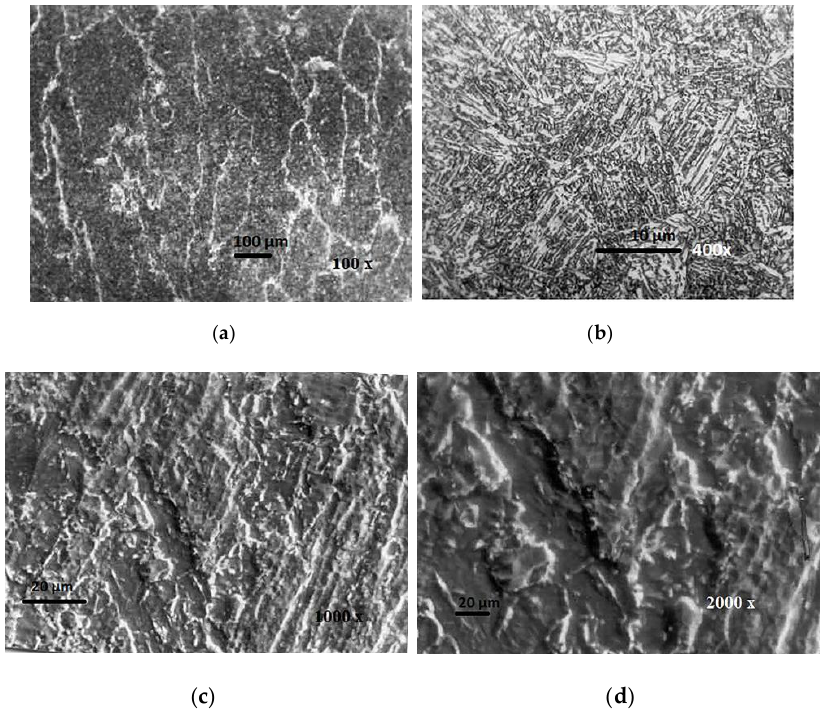
Figure 11. OM ( a , b ) and SEM ( c , d ) microstructure of WM created by electrode No.1.2.